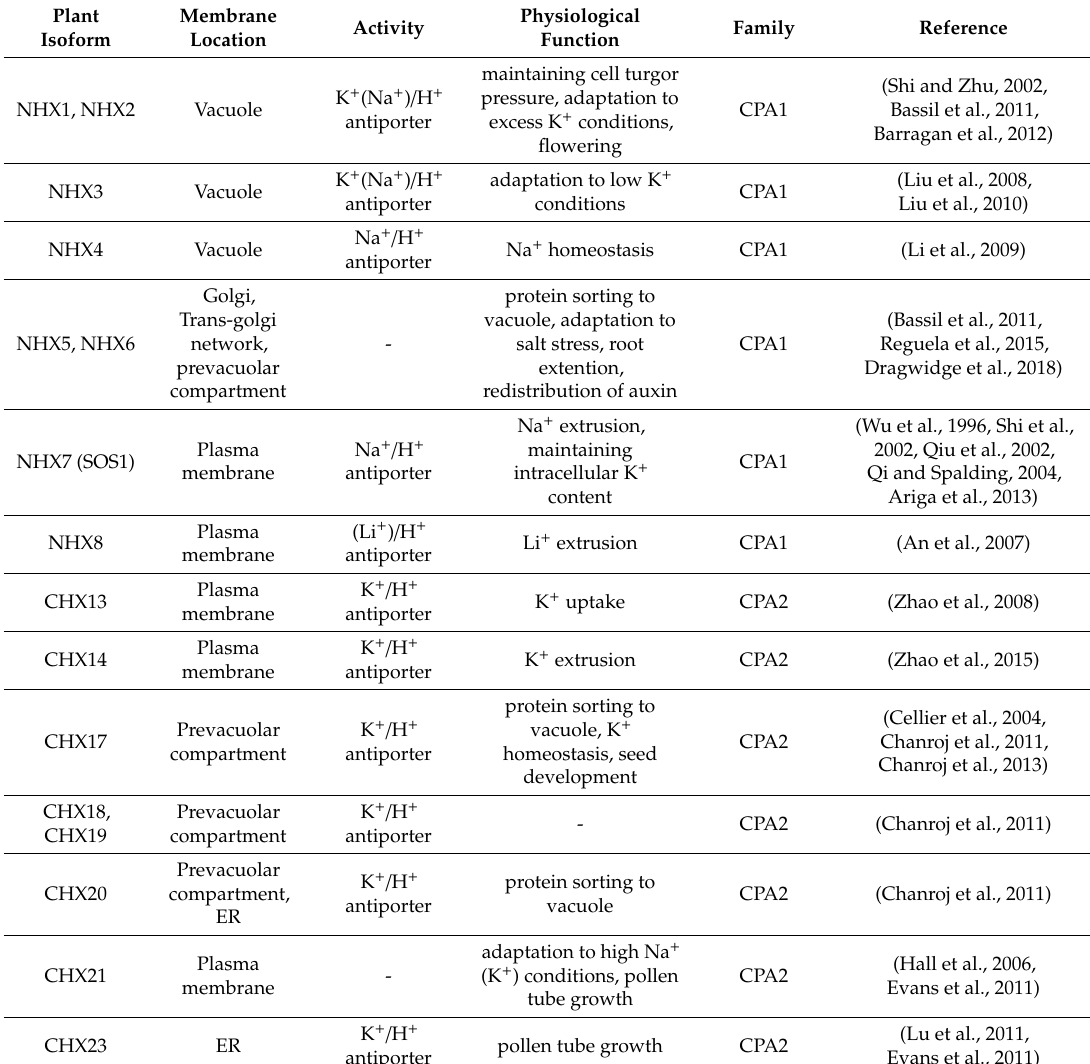
Table 3. CPAs in Arabidopsis